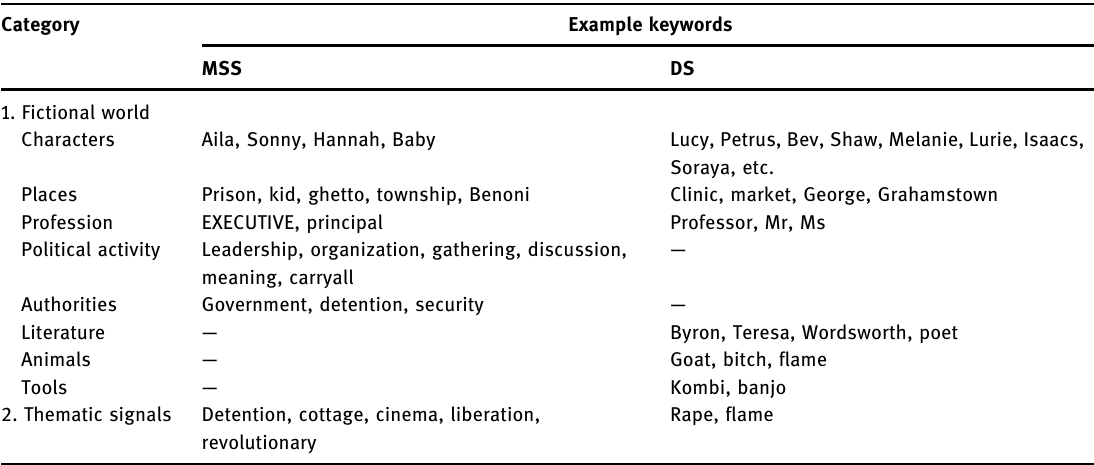
Table 3: Comparative classi fi cation of fi ctional world and thematic signal keywords in MSS and DS with examples